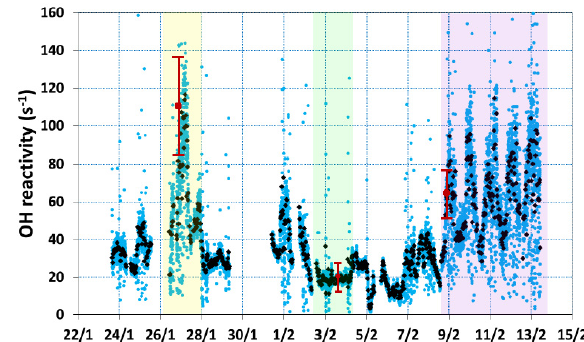
Fig. 8. OH reactivity time series (2 min blue dots; 30 min black diamonds). Errors bars corresponding to the estimated uncertainty are given for three levels of OH reactivity, low (20 s − 1 ) , medium (60 s − 1 ) and high (110 s − 1 )